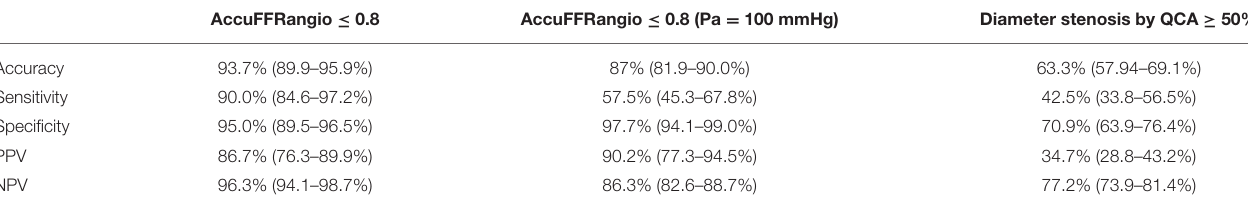
TABLE 3 | Diagnostic performance of AccuFFRangio for per-vessel.